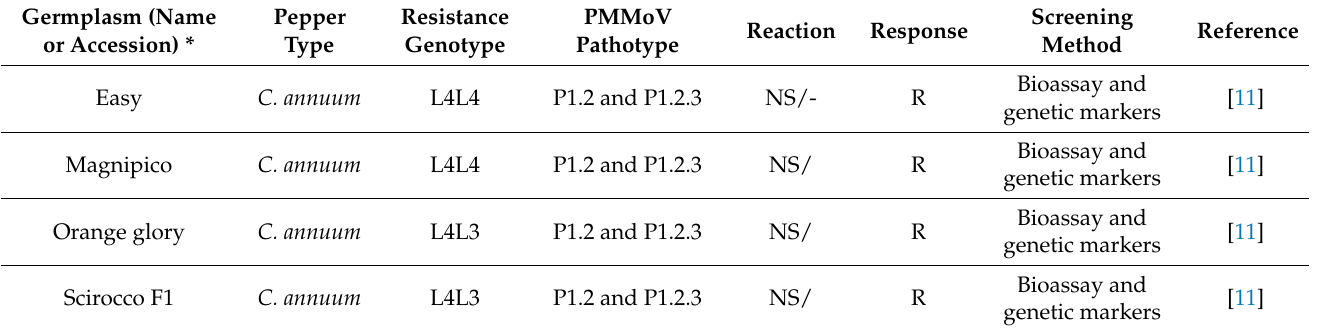
Table 4. Pepper genetic resources with resistance against